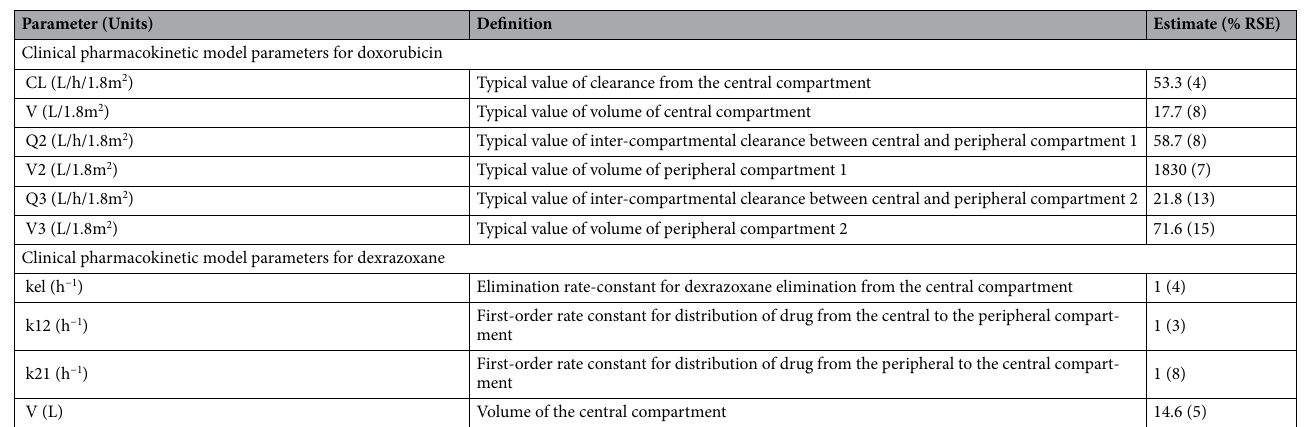
Table 2. Parameter estimates for the clinical pharmacokinetic (PK) models for DOX ( top ) and DEX ( bottom ). % RSE = % relative standard error in the model